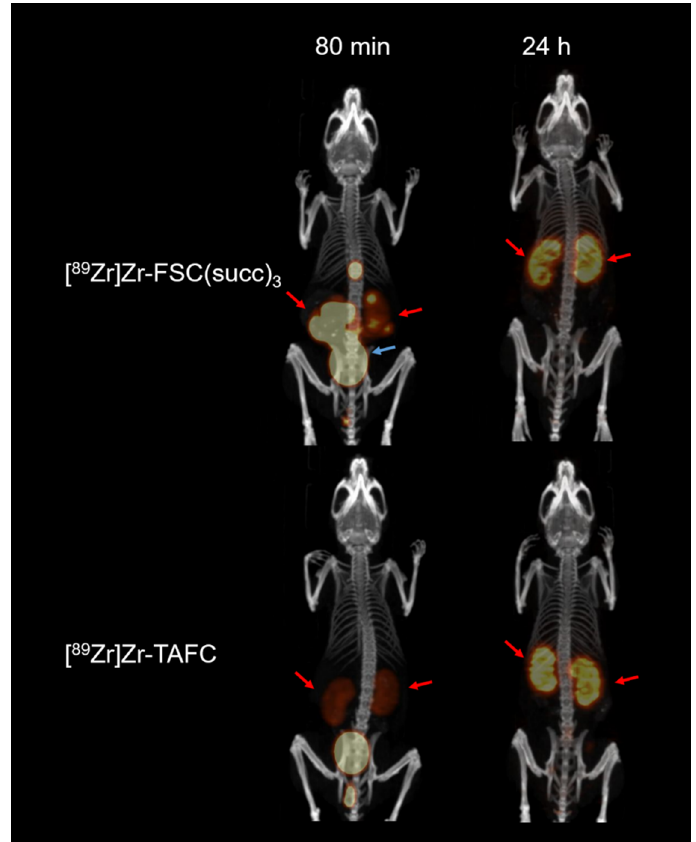
Figure 6. Micro-positron emission tomography/computer tomography images at 80 min p.i. and 24 h p.i. of BALB/c mice injected with either [ 89 Zr]Zr-FSC(succ)3 or [ 89 Zr]Zr-TAFC. Red arrow indicator: kidneys; blue arrow indicator: bladder. The single focal accumulation in the image of [ 89 Zr]Zr-FSC(succ)3 80 min p.i. is related to gall bladder activity, additionally some activity in small bowel appears, which disappears at 24 h p.i.